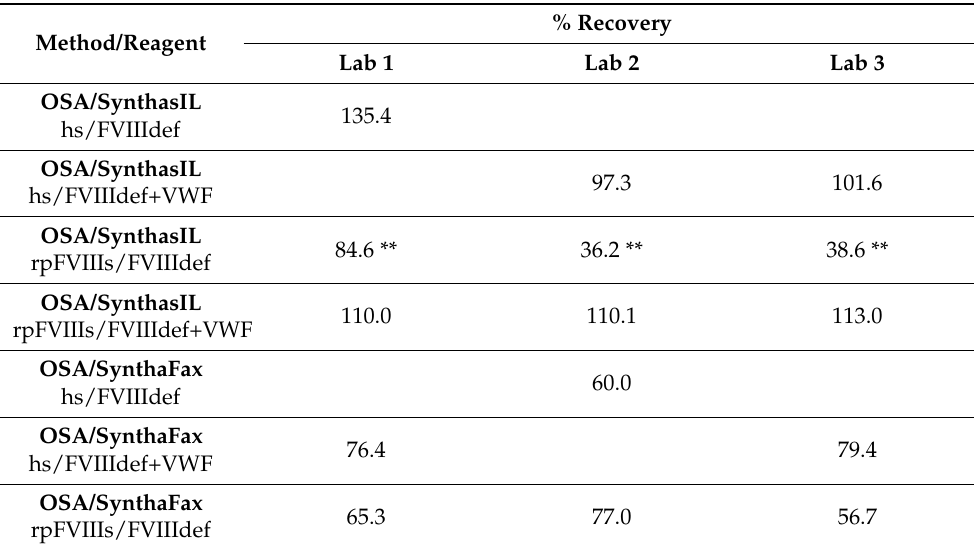
Table 2. Analytical accuracy of all the methods